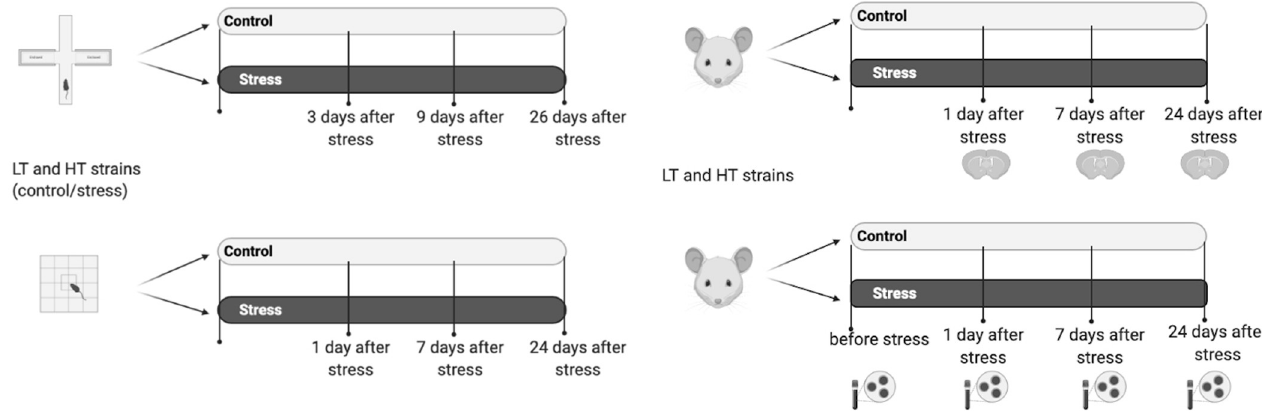
Fig 1. A timeline of the experiments. A–behavioral tests, B–blood smears (bottom) and brain immunohistochemistry (top), HT—animals with high excitability threshold, LT–animals with low excitability threshold.